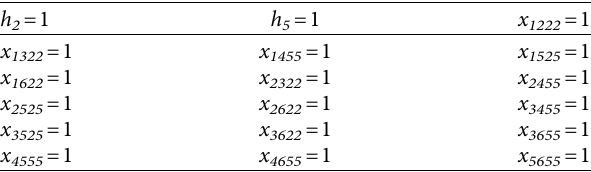
Figure 2: Hub-and-spoke network composed of six cities. Table 5: Arrangements of hub-and-spoke